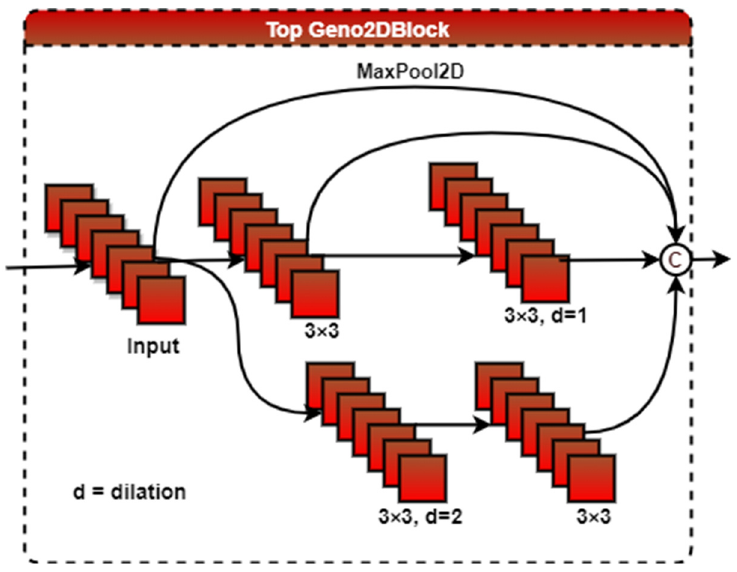
Figure 9. The Framework of Geno2Dblock.